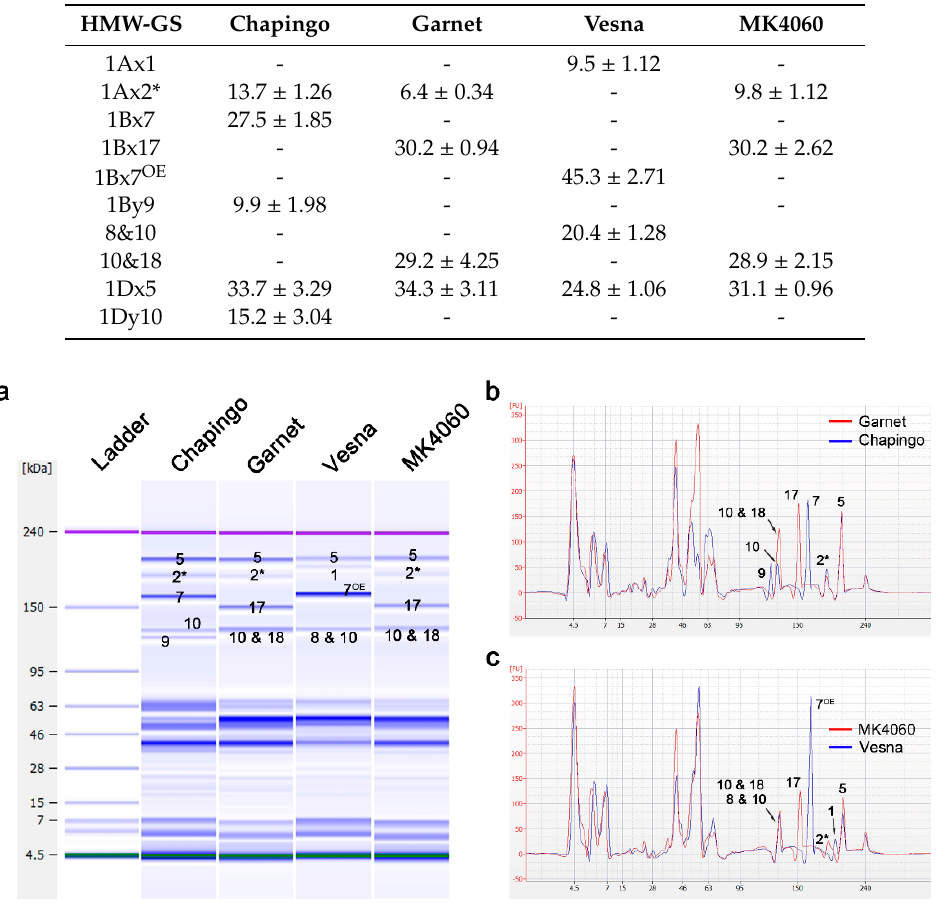
Figure 3. Identification of the 10 & 18 subunit on Lab-on-a-chip. ( a ) The gel-like image of HMW-GS. ( b ) Comparison of the protein quantities between 1Dy10 and 10 & 18 by electropherogram. ( c ) Comparison of the protein quantities between 8 & 10 and 10 & 18 by electropherogram. Six micrograms of diluted extracted glutenin proteins with denaturing solution were separated by the 2100 Bioanalyzer. The electropherograms were overlaid with the 2100 Expert program. The small numbers on the image mean each HMW-GS, such as 5 is 1Dx5 and 2* is 1Ax2*. Table 3. Relative protein quantity of HMW-GS for 10 & 18 identification by Lab-on-a-chip. The relative protein quantity of each HMW-GS was analyzed by the band peak area on the electropherogram. Three independent experiments were performed. Values are the mean (%) ± SD.